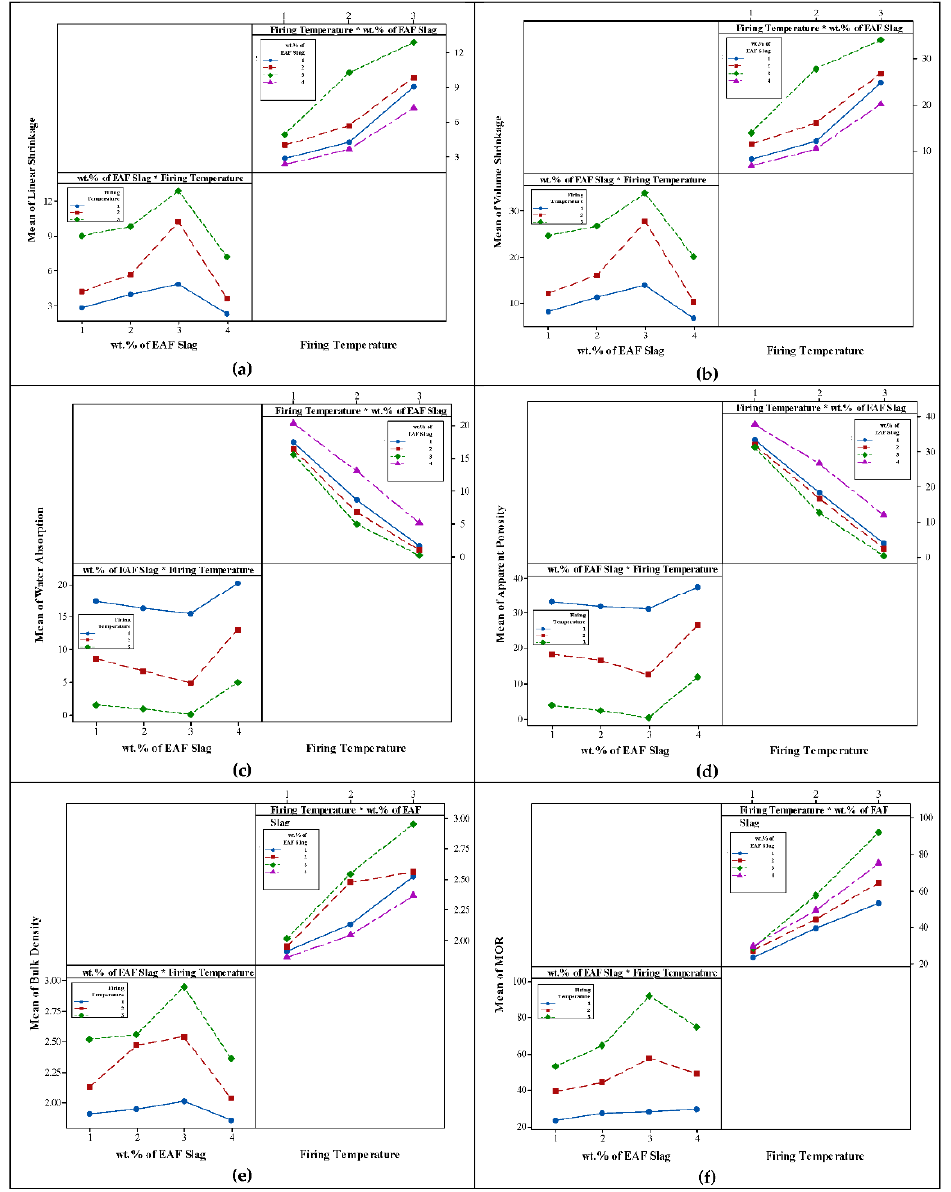
Figure 3. Interaction plot of ( a ) linear shrinkage, ( b ) volume shrinkage, ( c ) water absorption, ( d ) water absorption, ( e ) bulk density, ( f ) MOR, and their correlations.